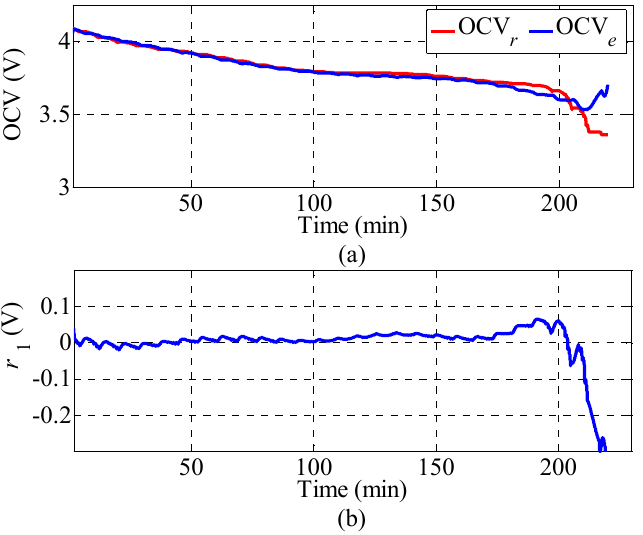
Figure 6. Estimated open-circuit voltage (OCV) and the residual r 1 : ( a ) OCV; ( b ) r 1 .